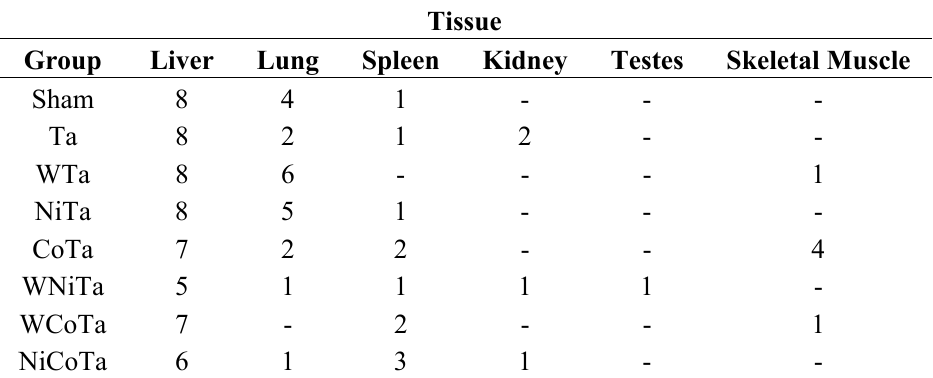
Table 3. Tumor locations in 24-month experimental